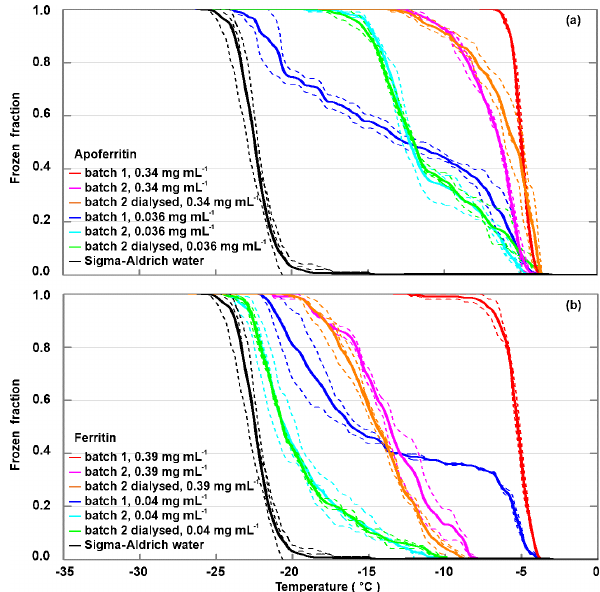
Figure 3. Batch dependence of the IN activity of apoferritin and ferritin for two different concentrations. (a) Frozen fraction as a function of temperature for batches 1 and 2 of apoferritin solutions with concentrations of 0.34mgmL − 1 and 0.036mgmL − 1 and a dialysed solution of batch 2 prepared with the lower concentra- tion (see Material and methods for details). (b) Frozen fraction as a function of temperature for batches 1 and 2 of ferritin solutions with concentrations of 0.39 and 0.04mgmL − 1 and a dialysed so- lution from batch 2 prepared with the lower concentration. Two to three DRINCZ experiments were performed for each concentration (dashed lines), and the mean is shown as the thick solid